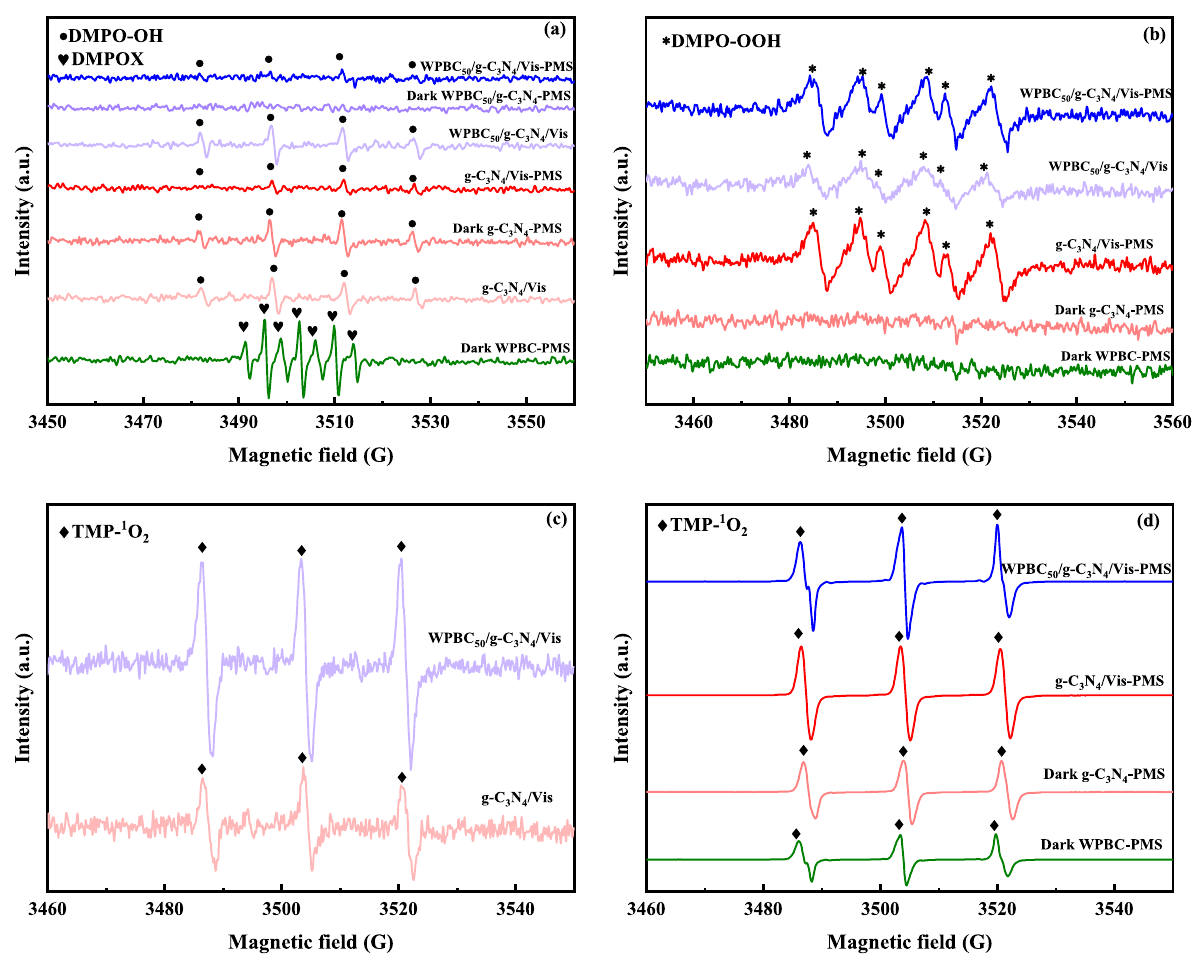
Fig. 7 EPR spectra of different reactive oxygen species in different systems, a DMPO-OH and DMPOX spectra using 80 mM DMPO for 10 min reaction, b DMPO-OOH spectra using 80 mM DMPO